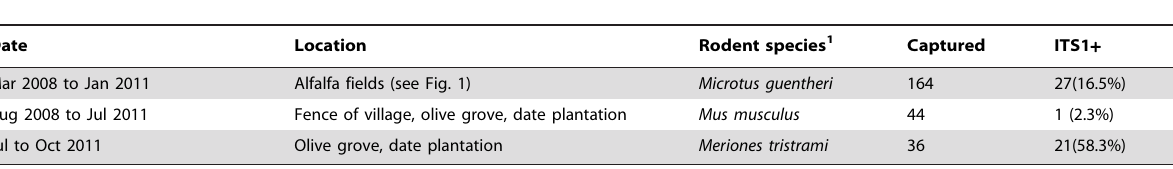
Table 5. Rodent population and Leishmania infection